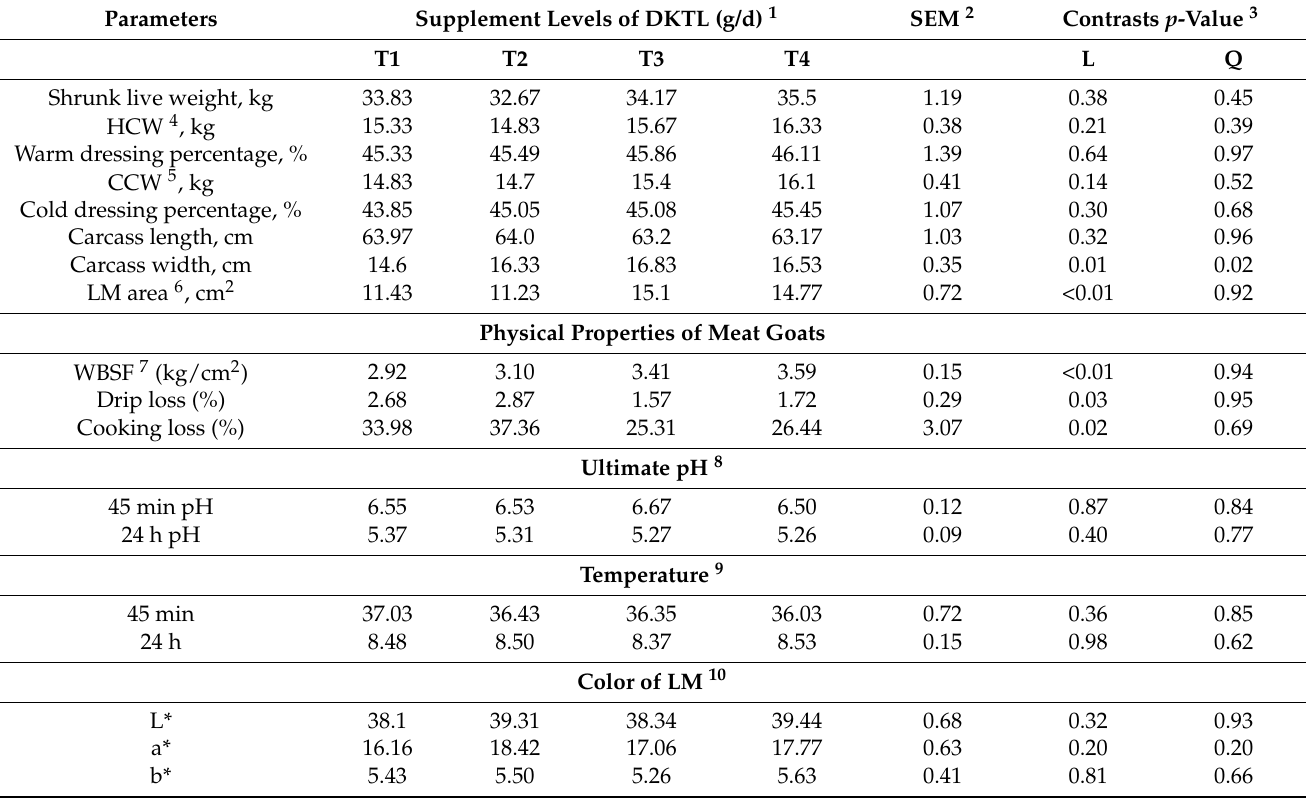
Table 4. Effects of Kratom leaves supplement on slaughtered carcass characteristics of fattening